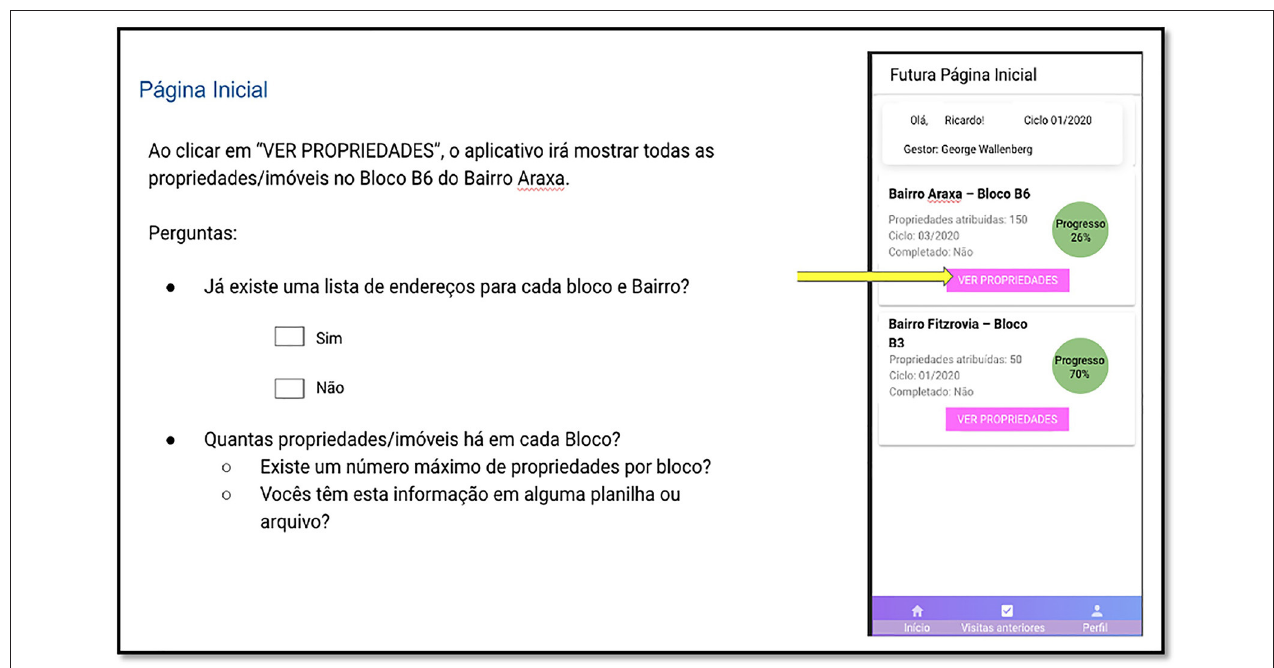
FIGURE 3 | Example of the slide containing a screenshot from the app (Right) and the questions (in Portuguese) to be discussed with the participants (Left)